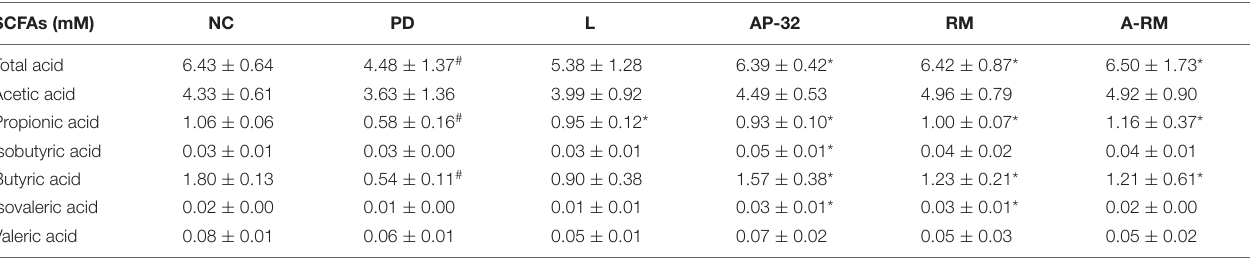
FIGURE 6 | The effect of AP-32, RM, and ARM on antioxidative enzyme activities in serum. (A) Glutathione peroxidase (GPx) activity, (B) superoxide dismutase (SOD) activity. Data are expressed as mean ± SEM ( n = 5 rats/group). # p < 0.05 PD group compared to NC group. * p < 0.05 L, AP-32, RM, and A-RM groups compared to PD group. All data were evaluated by one-way ANOVA with Tukey’s post hoc test. TABLE 4 | The effect of AP-32, RM, and A-RM on fecal SCFAs profiles after 8 weeks of